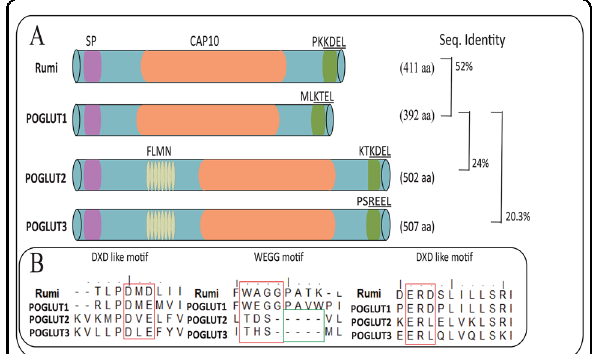
Fig. 3 A comparison of structural domains of POGLUTs including Rumi. A O -glucosyltransferases have a signal peptide (SP) at the beginning of sequence, a CAP10 domain, and a ER-retention signal. Both KTEL and REEL retention signals have a lower af fi nity for ERD receptors than the KDEL signal. POGLUT1 shares 52% identity with Rumi and is the only enzyme that can rescue O- glucosylation function in rumi mutant fl ies. Although POGLUT2 and 3 show O - glucosyltransferase activity, but both enzymes are unable to rescue Rumi loss-of-function phenotype and only share 24% and 20.3% identity with POGLUT1, respectively, indicating different target sequence for modi fi cation. B Multiple sequence alignment of glucosyltransferases indicates the presence of DXD-like motifs, whose mutation can abolish O -glucosylation activity of enzymes. Moreover, POGLUT 2/3 lacks the WEGG motif considered necessary for UDP- glucose